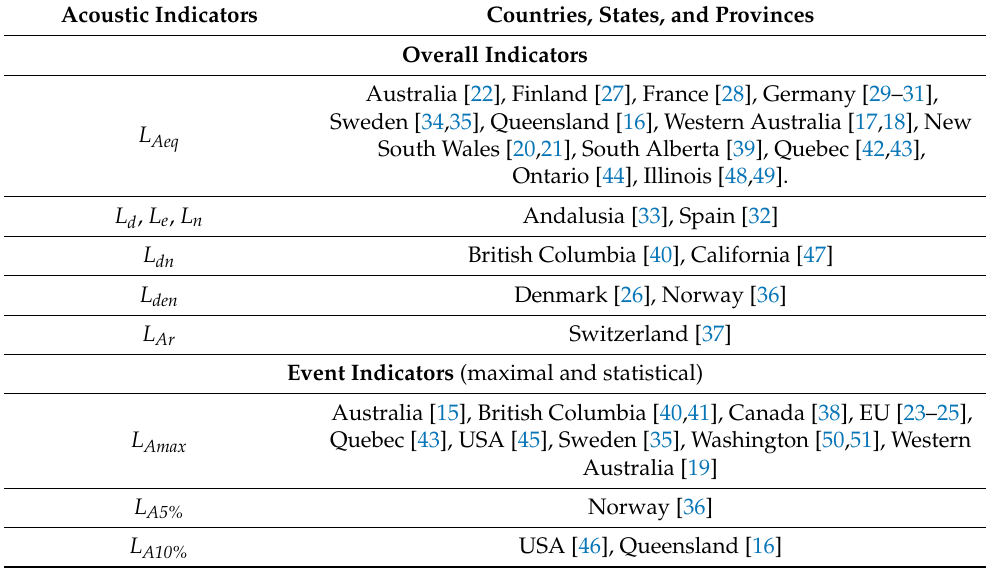
Table 5. Overall and event indicators used by countries, states, and provinces in noise policies and regulations. Acoustic Indicators Countries, States, and